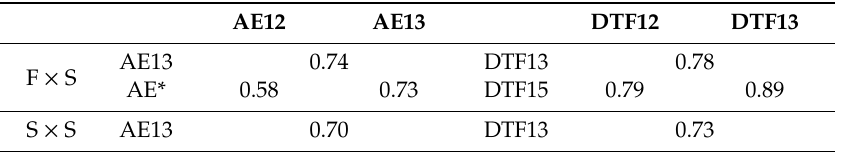
Table 3. Correlation coe ffi cients ( p < 0.01) among di ff erent experimental years of anther extrusion (AE and AE*, with years indicated), days to flowering (DTF), and plant height (PH) of the Fiia by Stormogul (F × S) and Svea by Stormogul (S × S) recombinant inbred line populations. (AE*: Anther extrusion data in 2015 calculated from average number of retained anthers (AR) from five panicles sampled randomly from each plot using the formula AE =